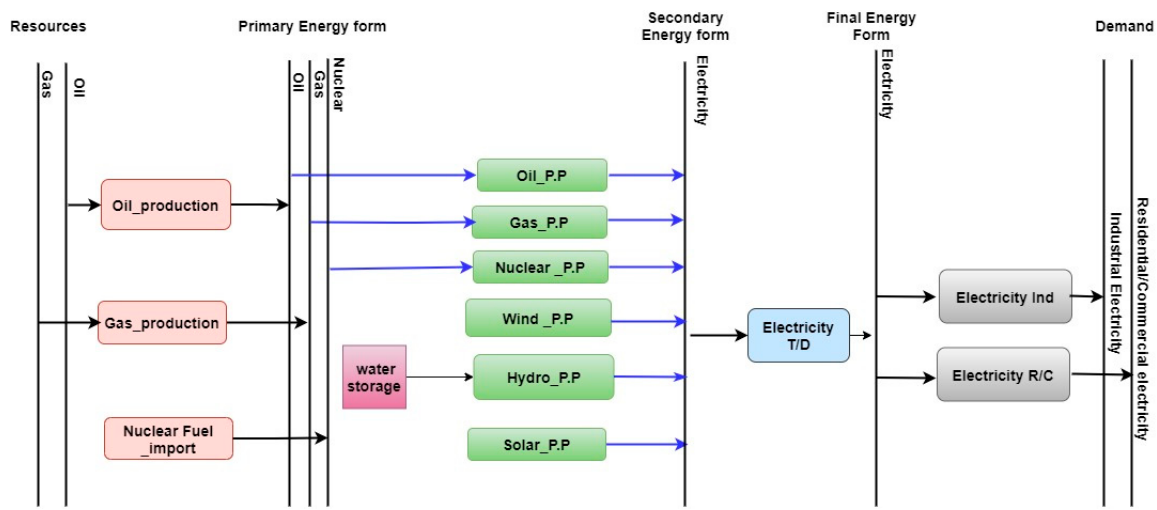
Figure 1. The energy chain modeling of Nigeria showing various energy resources and forms simulated in MESSAGE code for various power plants to final electricity. Table 1. General input data used in MESSAGE code for both scenarios using a base year of 2015 and modeling period of 45 years.